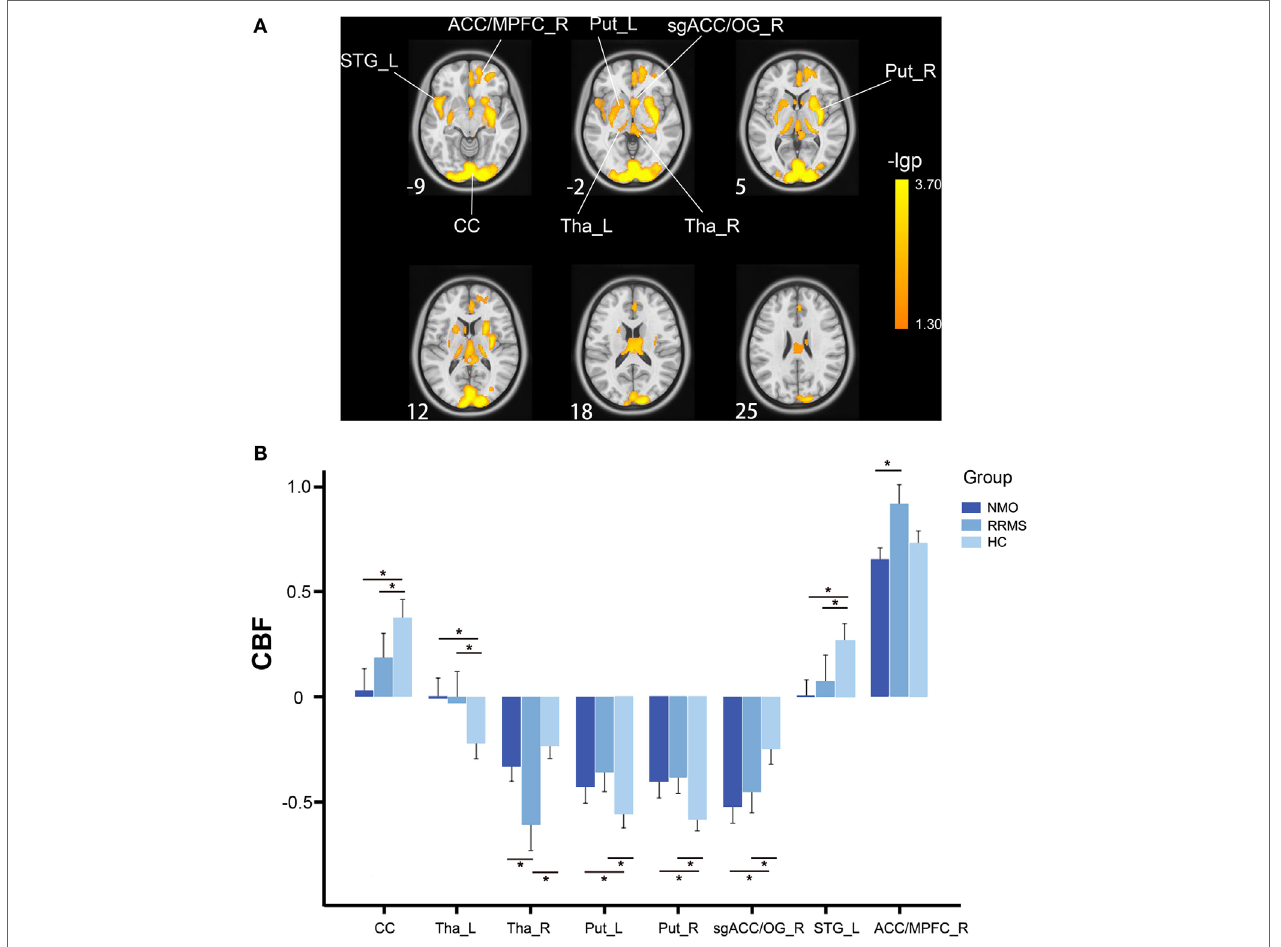
FigUre 1 | CBF differences among the relapsing-remitting multiple sclerosis, NMO, and control groups without GMV correction ( P < 0.05, FWE-corrected). (a) Voxel-based analysis shows brain regions with significant CBF differences among the three groups using age and gender as nuisance variables ( P < 0.05, FWE-corrected). (B) Bar plots show CBF differences between every two groups. Error bars are SEs. * P < 0.05. Abbreviations: ACC, anterior cingulate cortex; CBF, cerebral blood flow; CC, calcarine cortex; FWE, family-wise error; L, left; MPFC, medial prefrontal cortex; Put, putamen; R, right; sgACC, subgenual anterior cingulate cortex; STG, superior temporal gyrus; Tha,